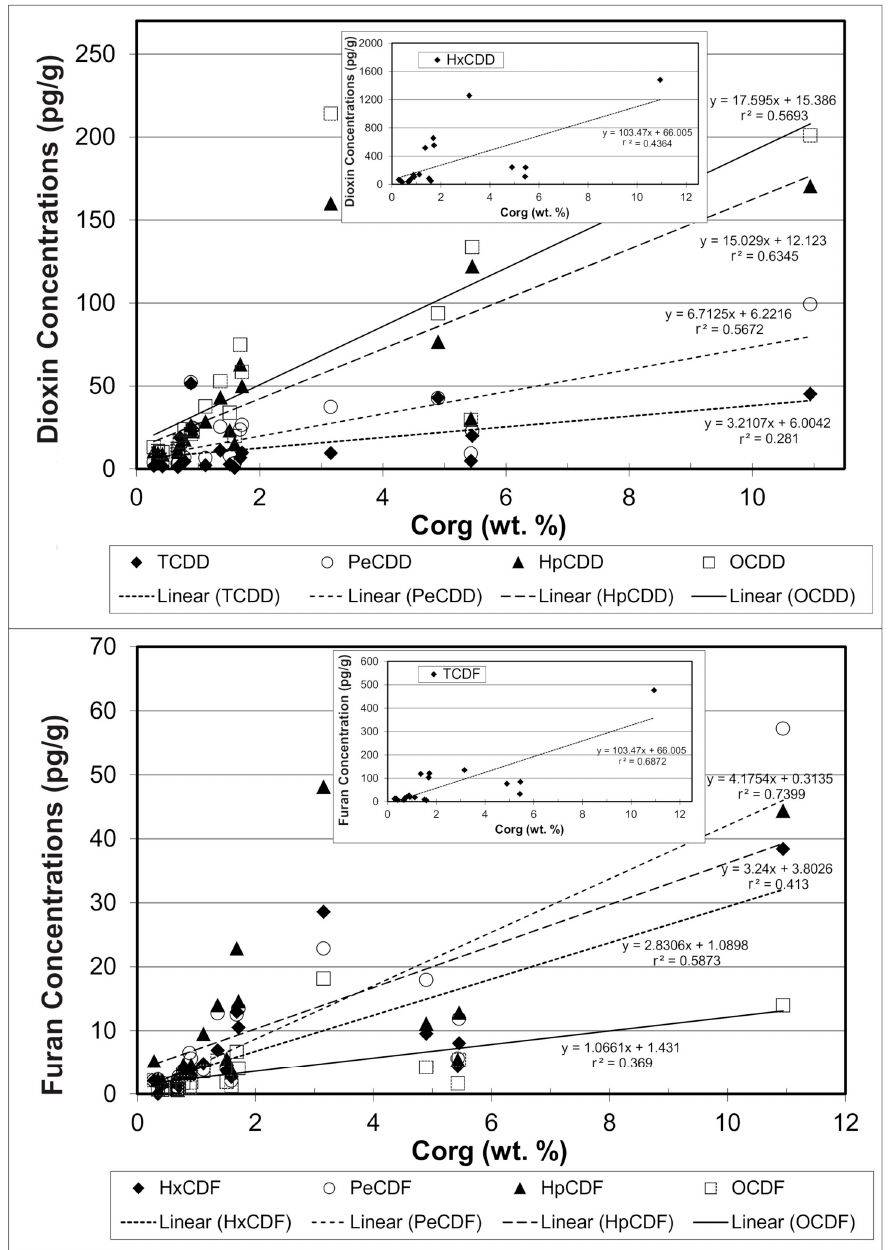
Figure 18. Plot showing the correlation between dioxin and furan concentration and organic matter concentrations in size fractionated sediments. Inset plots are those congeners, the HxCDD and TCDF, with concentrations that are significantly higher than other congeners.